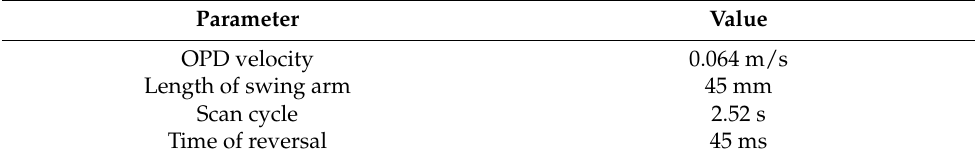
Table 1. The performance index of the moving mirror control system.